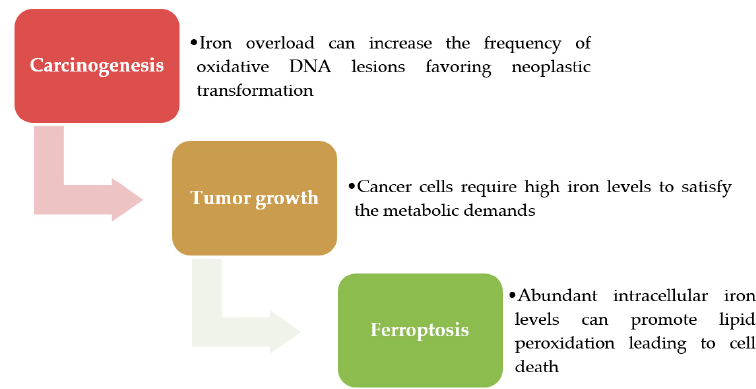
Figure 1. Iron in cancer. Iron can promote carcinogenesis by oxidative stress that increases DNA damage. Following neoplastic transformation, tumors utilize various mechanisms to maintain the high intracellular iron free levels necessary for tumor growth. Over time the iron overload could become deleterious by inducing lipid peroxidation and ferroptosis.